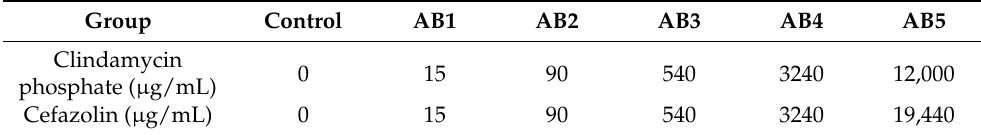
Table 1. Experimental concentrations of clindamycin phosphate and